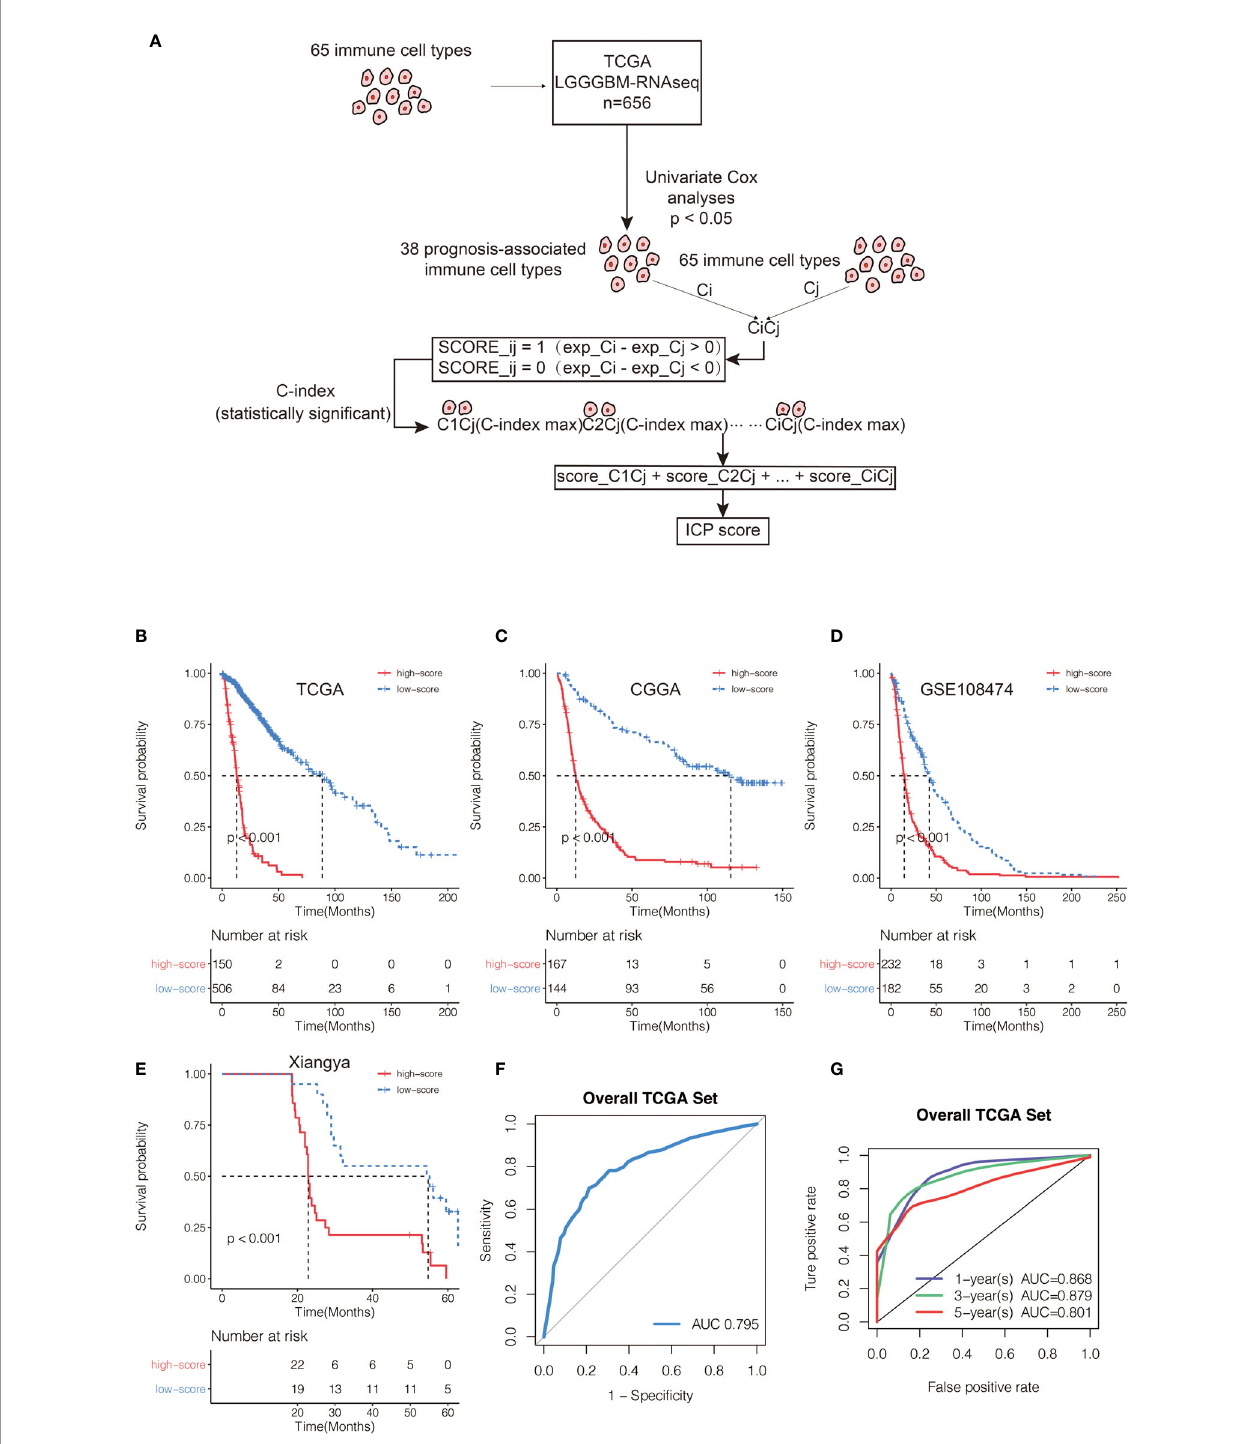
FIGURE 1 | (A) Flow diagram of the cell pair algorithm. Kaplan – Meier curves for the two ICP score groups in (B) TCGA, (C) CGGA, and (D) GSE108474, respectively. Log-rank test, P < 0.001. (E) Kaplan – Meier curves for the two ICP score groups in the Xiangya cohort. Log-rank test, P < 0.001. (F) ROC curve measuring the sensitivity of ICP score in predicting the survival status of the patients. The area under the ROC curve was 0.795. (G) ROC curve measuring the sensitivity of ICP score in predicting the 1-year, 3-year, and 5-year survival of the patients. The area under the ROC curve was 0.868, 0.879, and 0.801,